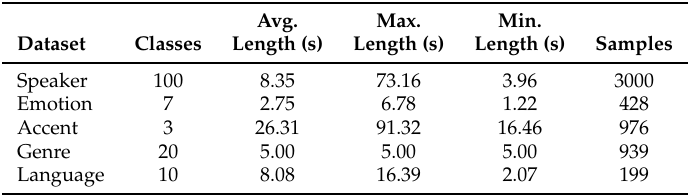
Table 5. Audio: Summary of audio